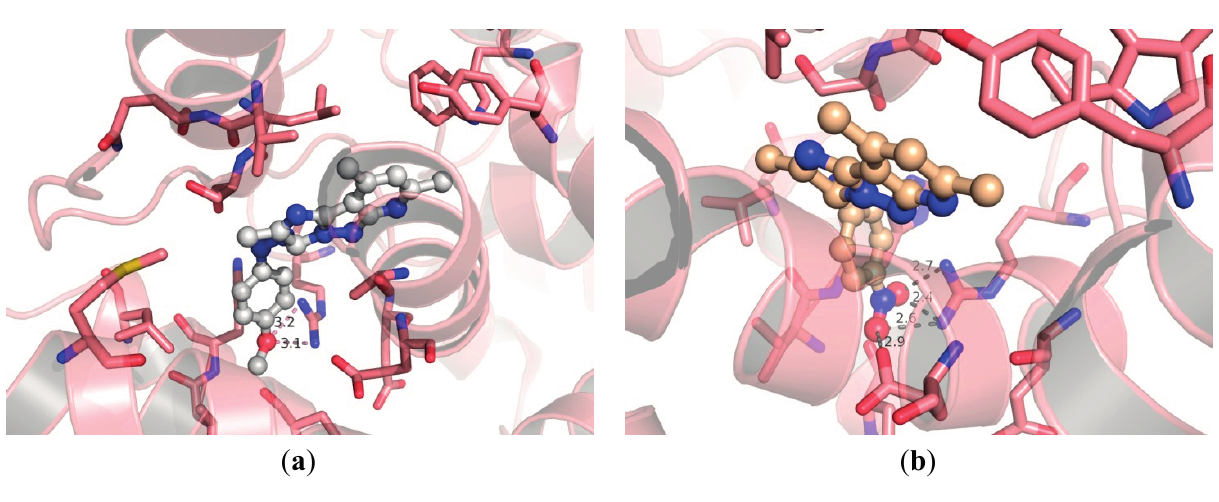
Figure 3. Hypothetical binding modes of compound 5c ( a ); and 5e ( b ) in COX-2 protein (PDB ID:3ln1). Dashed lines represent distances between heavy